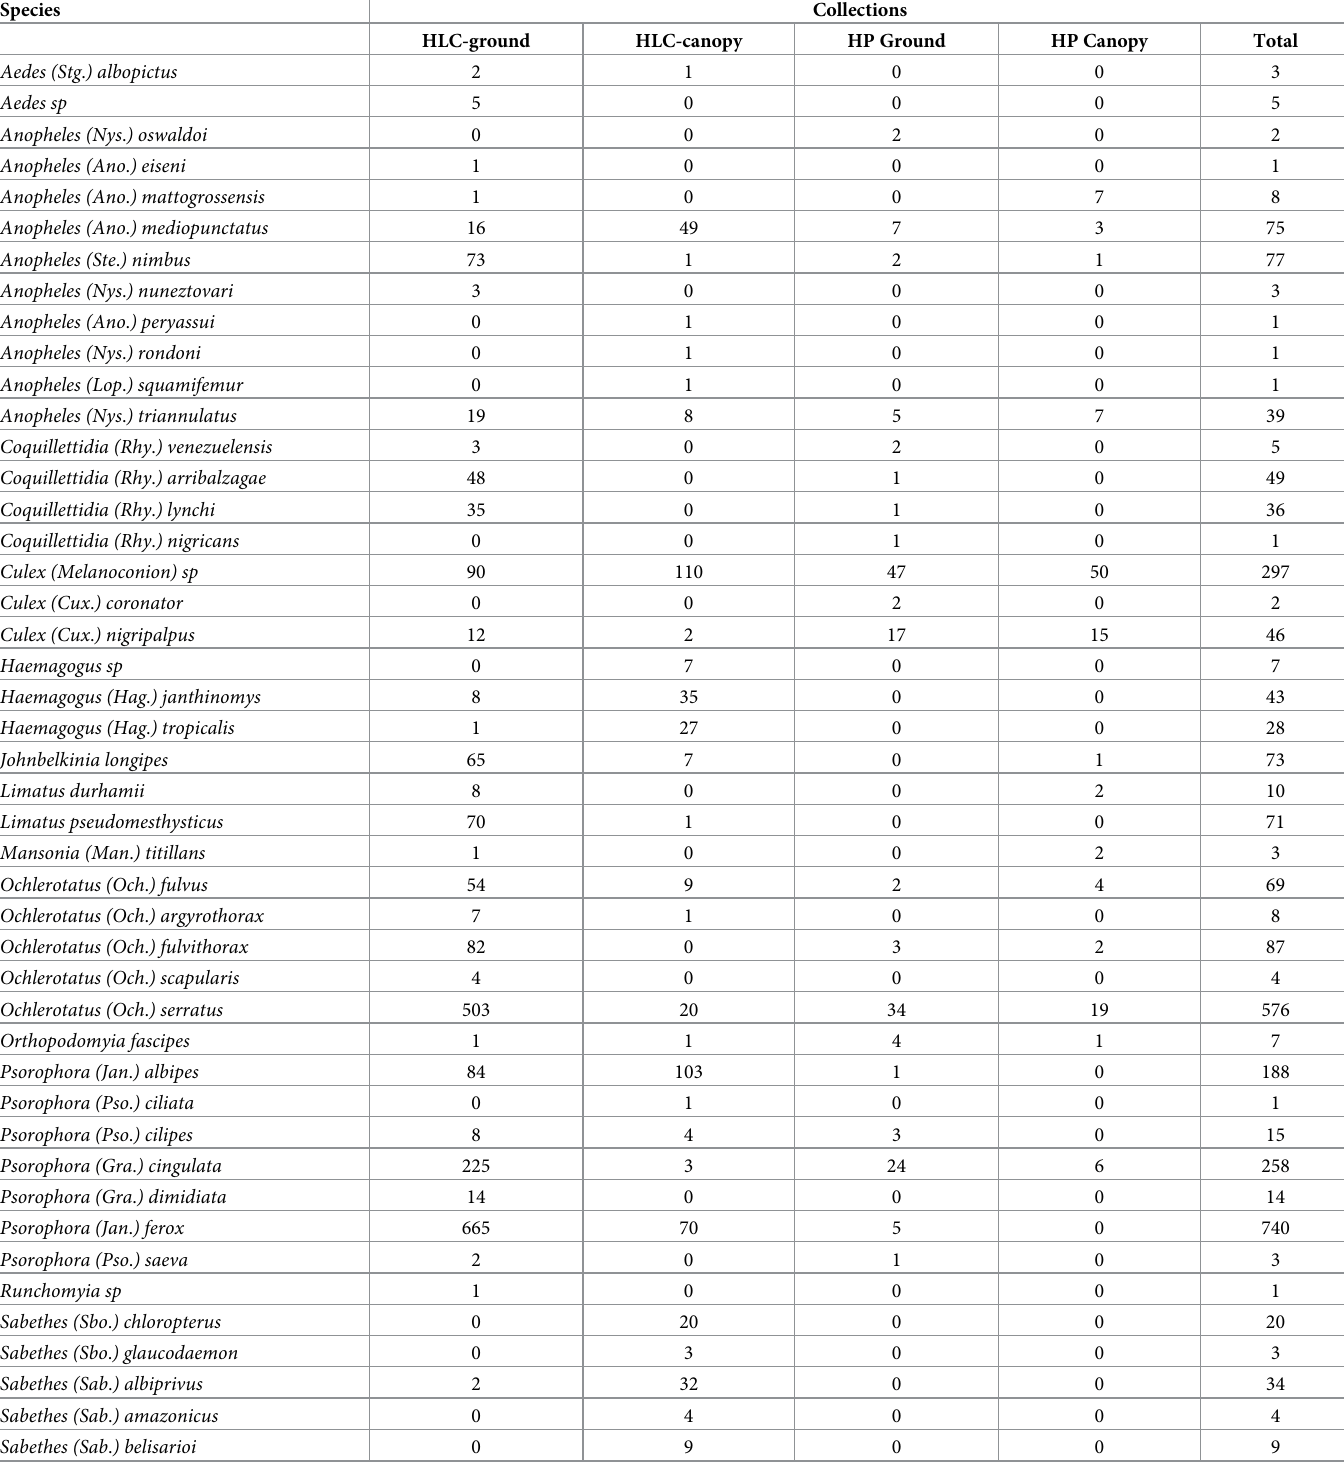
Table 1. Number of mosquitoes collected from the ground and canopy in platforms located at Principal and Gusm ã o roads in the rural settlement of Rio Pardo, Presidente Figueiredo, Amazonas State, Brazil, in 2016.